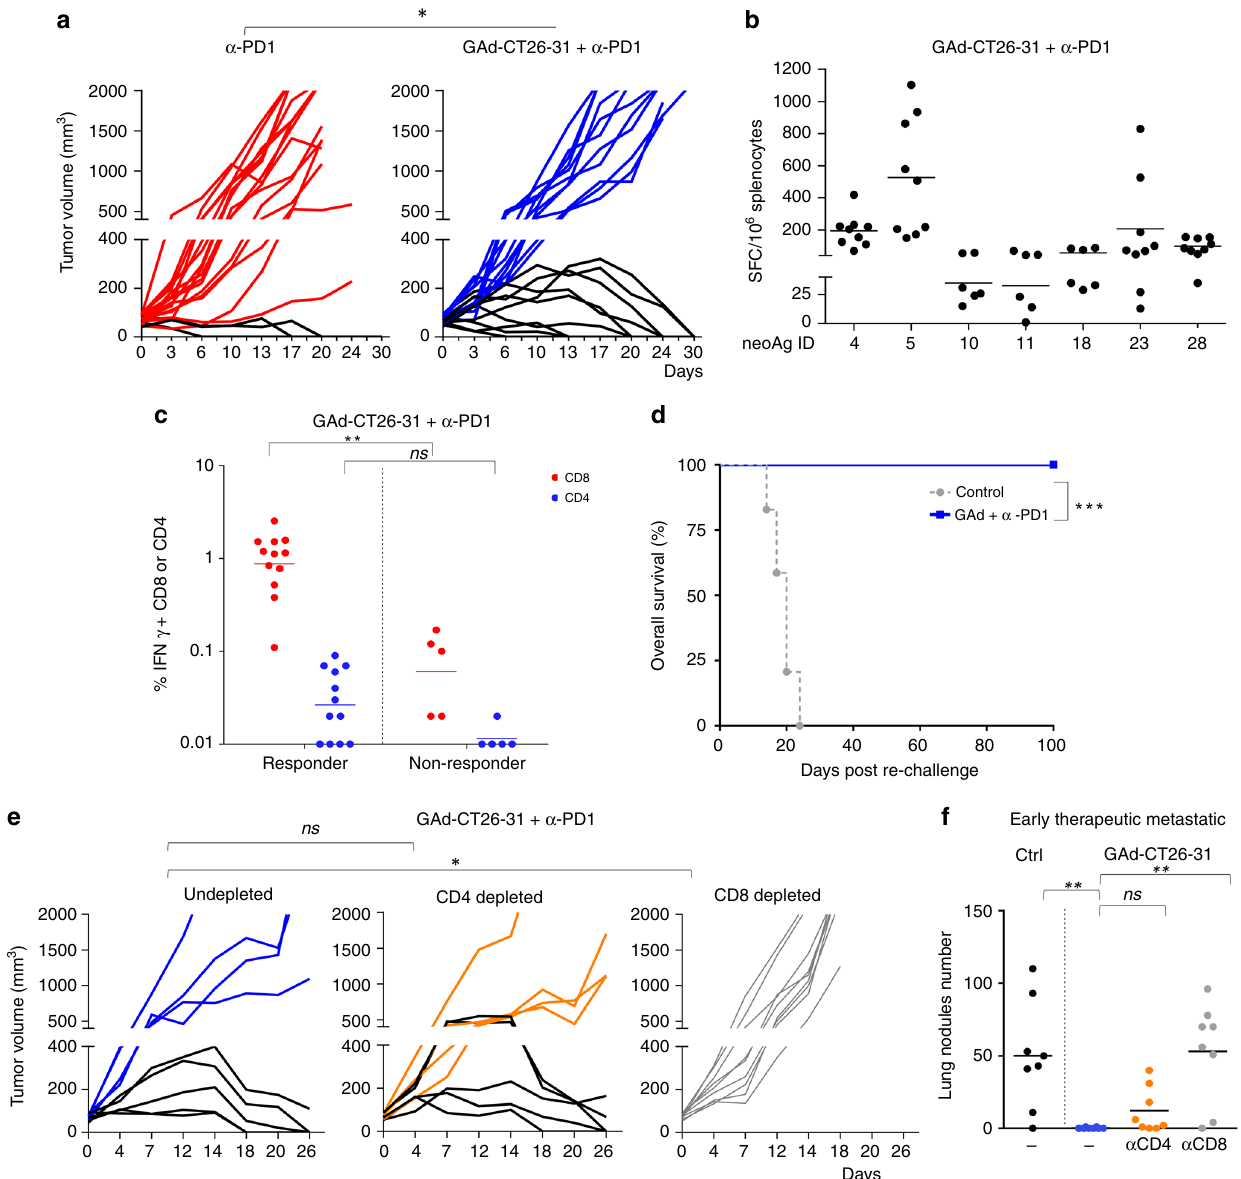
Fig. 3 Ef fi cacy of GAd in animals with high tumor burden requires the combination with anti-PD1. a Mice ( n = 20/group) were inoculated s.c. with CT26 cells. One week later, animals were randomized according to tumor volume and treated with anti-PD1 alone (left panel) or in combination with GAd-CT26-31 (right panel). Vaccine was administered at day 0 (i.m.), whereas anti-PD1 was given twice per week until day 16 (i.p.). Tumor growth over time is shown for individual mice. Red and blue curves represent non-responder mice, black curves indicate responder mice. Data are from three independent experiments (two- tailed Chi-Square test; * p <0.05). b Analysis of nAg-speci fi c T-cell responses quanti fi ed by IFN- γ ELISpot in responder mice (splenocytes) cured by the combination of GAd and anti-PD1. Responses against the immunogenic nAgs are shown ( n = 6 – 9 mice per group, representative of two independent experiments). c nAg-speci fi c T-cell responses measured by IFN- γ ICS in responder and non-responder mice treated with GAd-CT26-31 and anti-PD1. Percentages of IFN- γ + CD4 + and CD8 + T cells measured at day 30 upon peptides pool re-stimulation are shown. (two-tailed Mann – Whitney U test; ** p < 0.01, n.s., not signi fi cant). d Tumor-free mice treated with anti-PD1 and GAd-CT26-31 were challenged with a second CT26 tumor inoculum ( n = 10, at least three independent experiments). Animals survival after second challenge was monitored until 100 days post re-challenge. (Log-rank test; *** p <0.001). e Tumor growth in tumor bearing mice treated with GAd-CT26-31 and anti-PD1 and depleted for CD4 + or CD8 + T cells. Data represent at least two independent experiments. (Fisher exact test; * p <0.05). f Number of lung nodules measured in control mice or mice vaccinated with GAd-CT26-31 ( n = 8 per group from one experiment) and depleted for CD4 + or CD8 + T cells (two-tailed Mann – Whitney U test; ** p <0.01; n.s., not signi fi